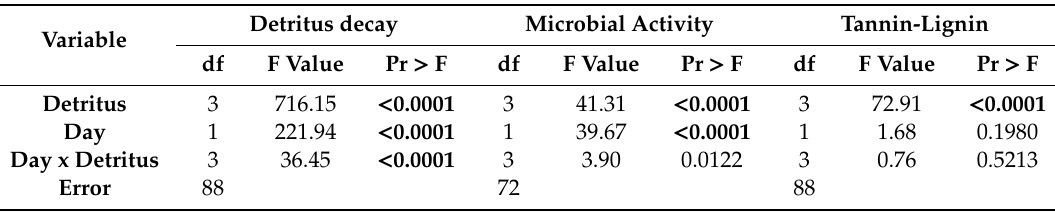
Table 3. Results from linear models for detritus decay rate, microbial activity (µwatts/mL), and tannin-lignin concentration (mg/L) (all log 10 transformed). Effects significant at experimentwise α = 0.05 (sequential Bonferroni) are shown in bold.